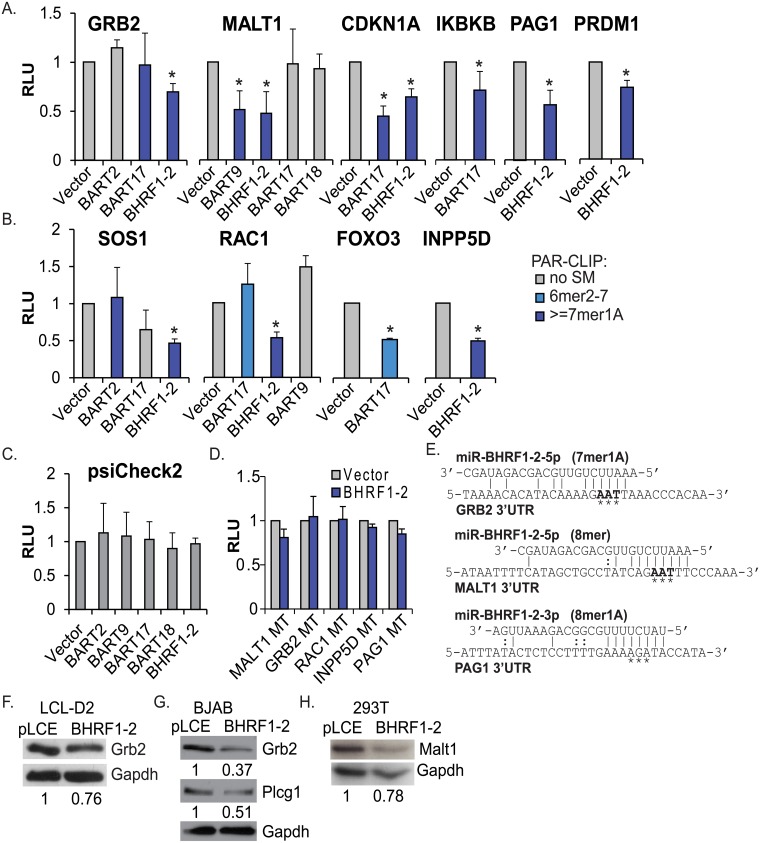
Validation of EBV miRNA targets.A-C. 293T cells were co-transfected with indicated 3’UTR luciferase reporters or psiCheck2 empty vector (C.) and EBV miRNA expression vectors (pLCE-based). 48–72 hrs post-transfection, cells were lysed and assayed for dual luciferase activity. PAR-CLIP interactions between EBV miRNAs and 3’UTRs are highlighted. SM = seed match. Reported are the averages of at least three independent experiments performed in triplicate. *By Student’s t-test, p<0.05. RLU = relative light units. D. Site-directed mutagenesis of BHRF1-2 miRNA seed match sites in target 3’UTRs abrogates knockdown. Luciferase assays were performed as described in A-C. Reported are the averages of at least three independent experiments performed in triplicate. E. Alignments showing the BHRF1-2 miRNA interaction sites and mutations (starred nucleotides) generated for the GRB2, MALT1, and PAG1 3’UTR reporters. F-H. Grb2, Plcg1, and Malt1 are inhibited in the presence of EBV miRNAs. In F. and G., western blot analysis was performed on lysates from BHRF1-2 miRNA mutant LCLs (LCL-D2) or EBV negative BJAB cells ectopically expressing GFP (pLCE) or the BHRF1-2 miRNAs. In H., western blot analysis was performed on lysates from 293T cells transiently transfected with pLCE-based miRNA expression vectors (72 hr post-transfection). Gapdh levels are shown as loading controls. Band intensities were quantified using ImageJ, normalized to loading controls, and reported relative to control cells (WT or pLCE).